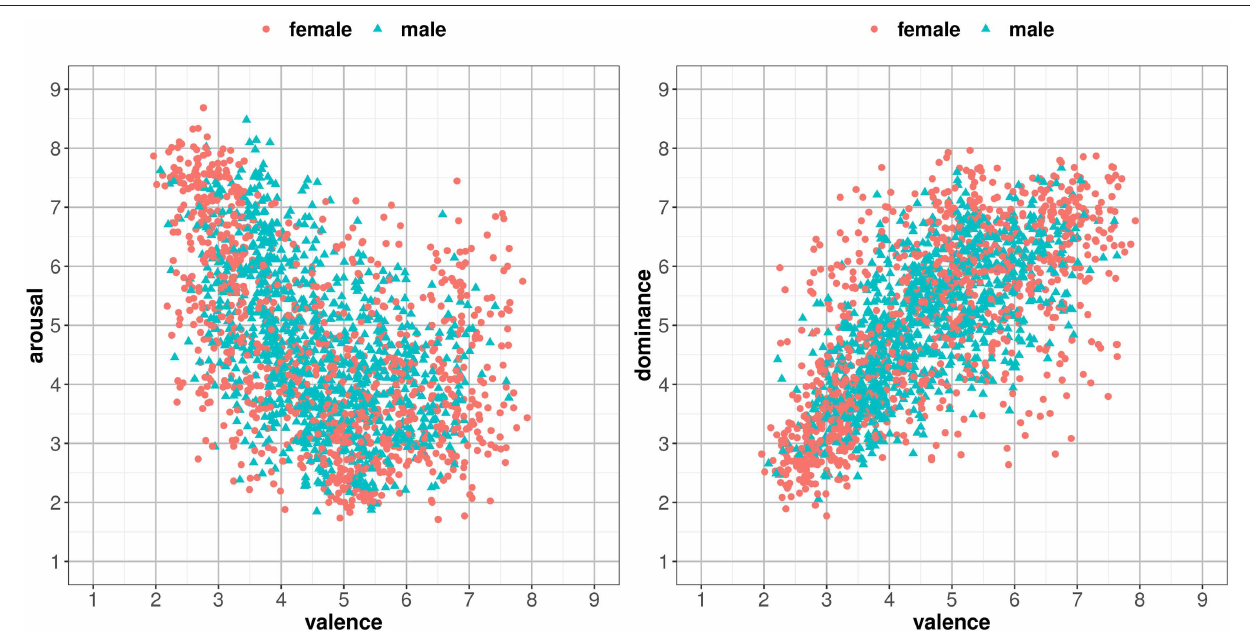
FIGURE 5 | Distributions of the 1,034 Spanish S-ANEW word ratings in the affective space defined by valence , and arousal (Left) and dominance (Right) , for both males and females.